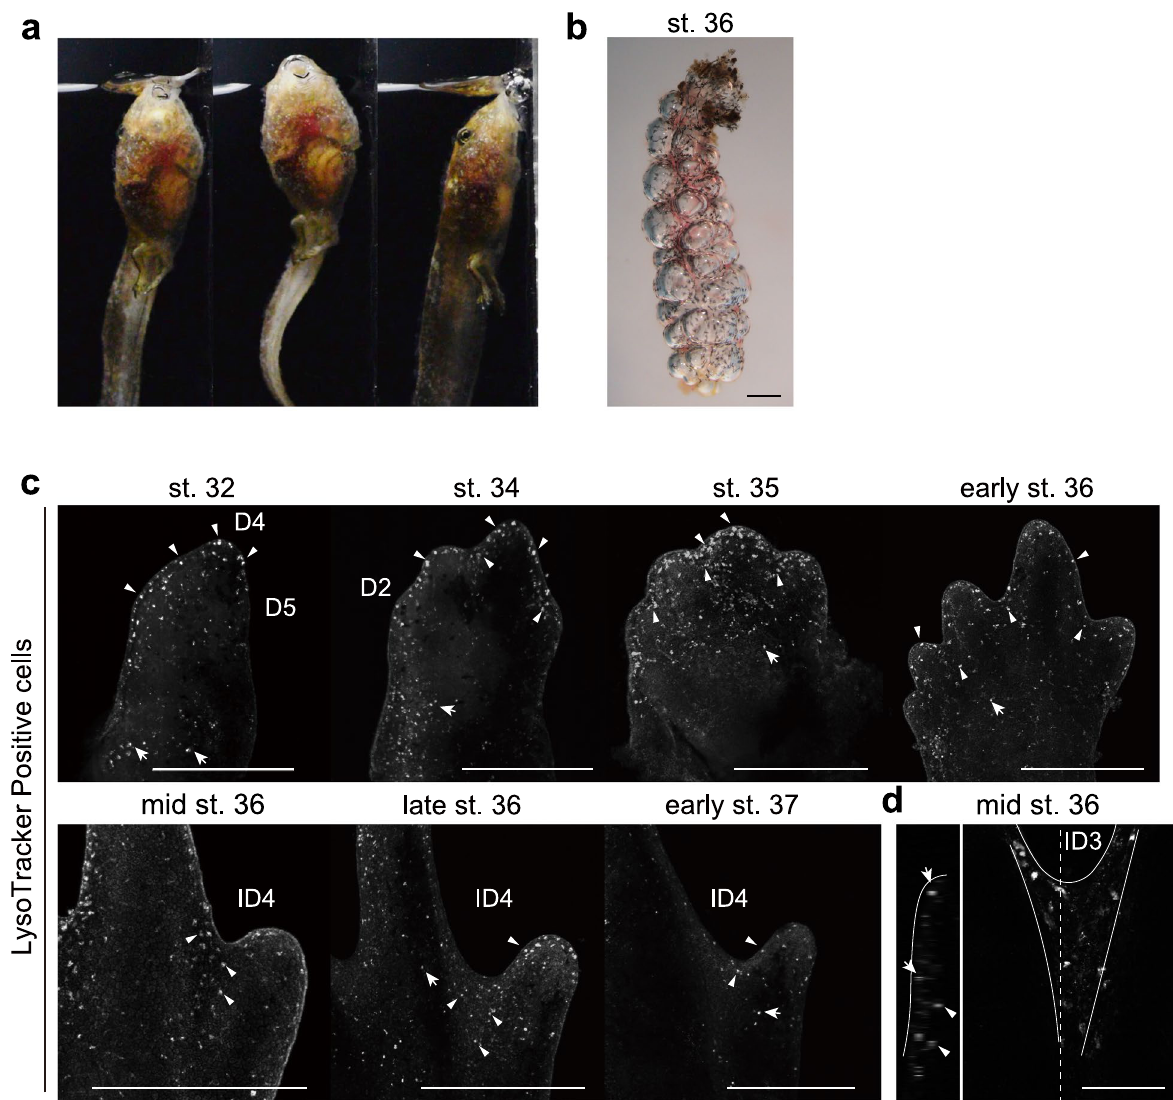
Fig. 1 Air-breathing behavior, and cell death during limb development in R. pirica . a Air–breathing behavior of R. pirica tadpoles. b A lung dissected from a stage 36 R. pirica tadpole. c Cell death (LysoTracker Red) in R. pirica hindlimbs. LysoTracker–positive cells were found in interdigital regions, and limb margin edges (arrowheads), and surface ectoderm (arrows). d Cell death (LysoTracker Red) in mid stage 36 R. pirica hindlimbs. Cell death was observed in both the ectoderm (arrows) and the mesenchyme (arrowheads), as revealed on the orthogonal (optical) section of a confocal stack. D2, 4–5: digits 2, 4, and 5; ID3, 4: interdigital regions 3 and 4. Scale bars, 500 μm in ( b ), ( c ) and 100 μm in ( d